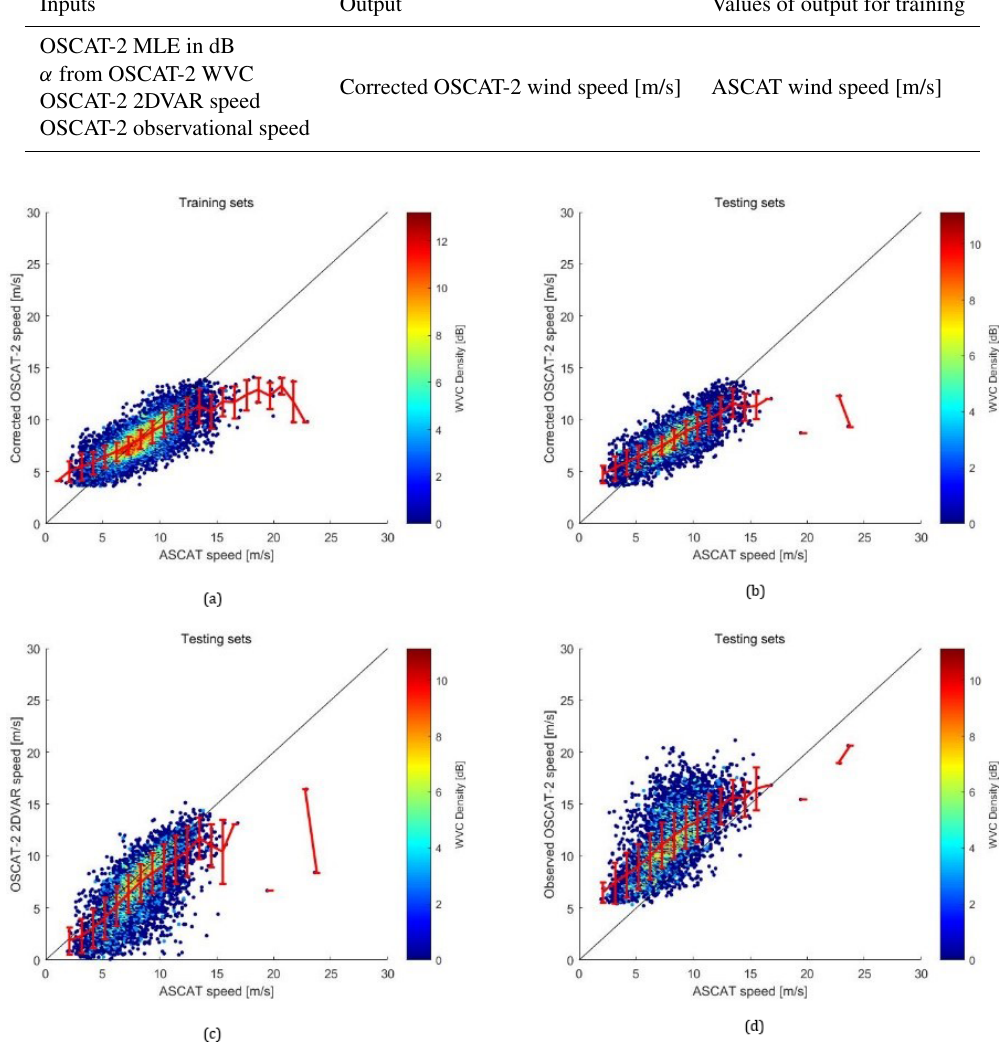
Figure 3. The corrected winds against accepted winds from ASCAT-A and ASCAT-B for the training set (a) and validation set (b–d) , where (b) the corrected, (c) the 2DVAR and (d) observational OSCAT-2 wind speed against ASCAT wind speed are